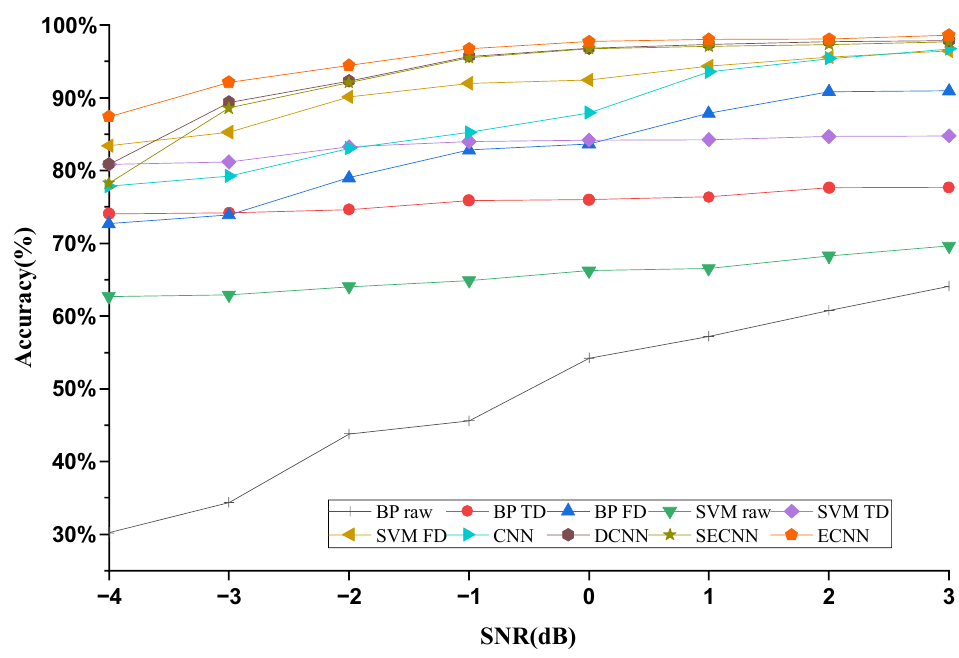
Figure 11. Accuracy curve of each method under different SNRs.